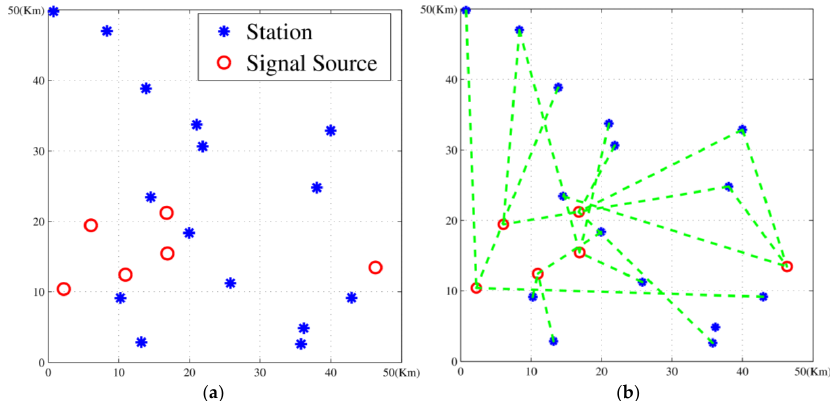
Figure 8. Passive location resource scheduling diagram with 15 stations and six tasks: ( a ) distribution of resources and tasks; ( b ) the scheduling plan: dotted green line represents task assignment. Table 4. Scheduling results of 15 stations and six tasks.